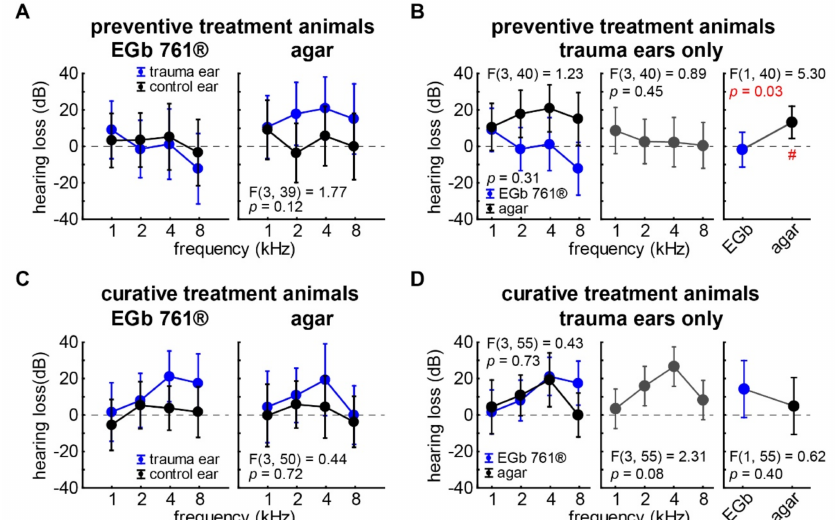
Figure 4. Hearing loss 3 weeks after trauma. ( A ) Results of the repeated-measurement ANOVA (factor ear : trauma ear = blue, control ear = black) interaction plot (factors frequency : 1, 2, 4, 8 kHz; application group : EGb 761 ® , agar) of hearing loss (dB) of the 16 animals in the preventive treatment group. Given are the mean values as filled circles and the 95% confidence intervals as whiskers, as well as the F-statistics of the interaction of all three factors on the ABR thresholds. For details of this ANOVA, see Table 2. ( B ) Results of the two-factorial ANOVA ( frequency and application group ) of the preventive animals’ trauma ears HL only. The # symbol indicates a significant single sample t -test vs. zero. ( C ) Results of the repeated-measurement ANOVA of hearing loss of the 21 animals in the curative treatment group. For details of this ANOVA, see Table 2. ( D ) Results of the two-factorial ANOVA ( frequency and application group ) of the curative animals’ trauma ears HL